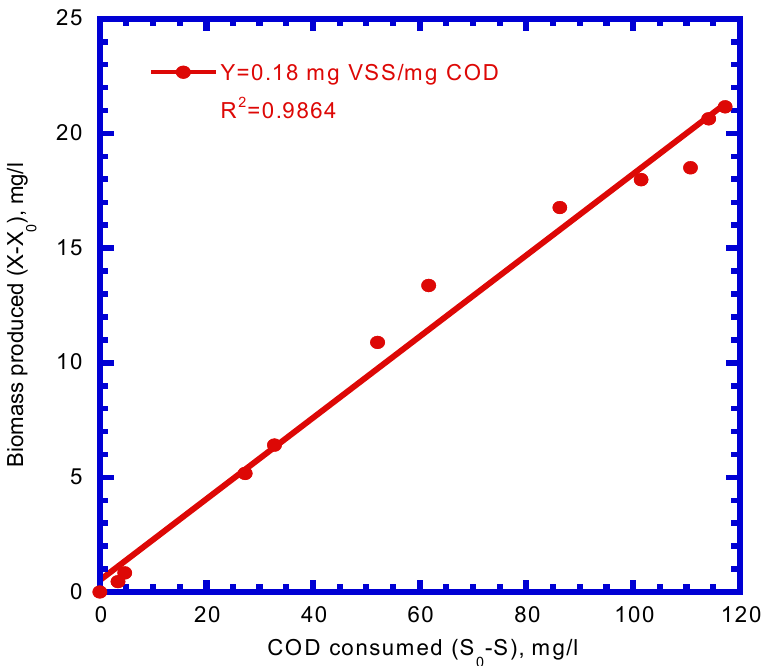
Figure 5. Batch kinetic experiment to evaluate the yield coefficient ( Y ).